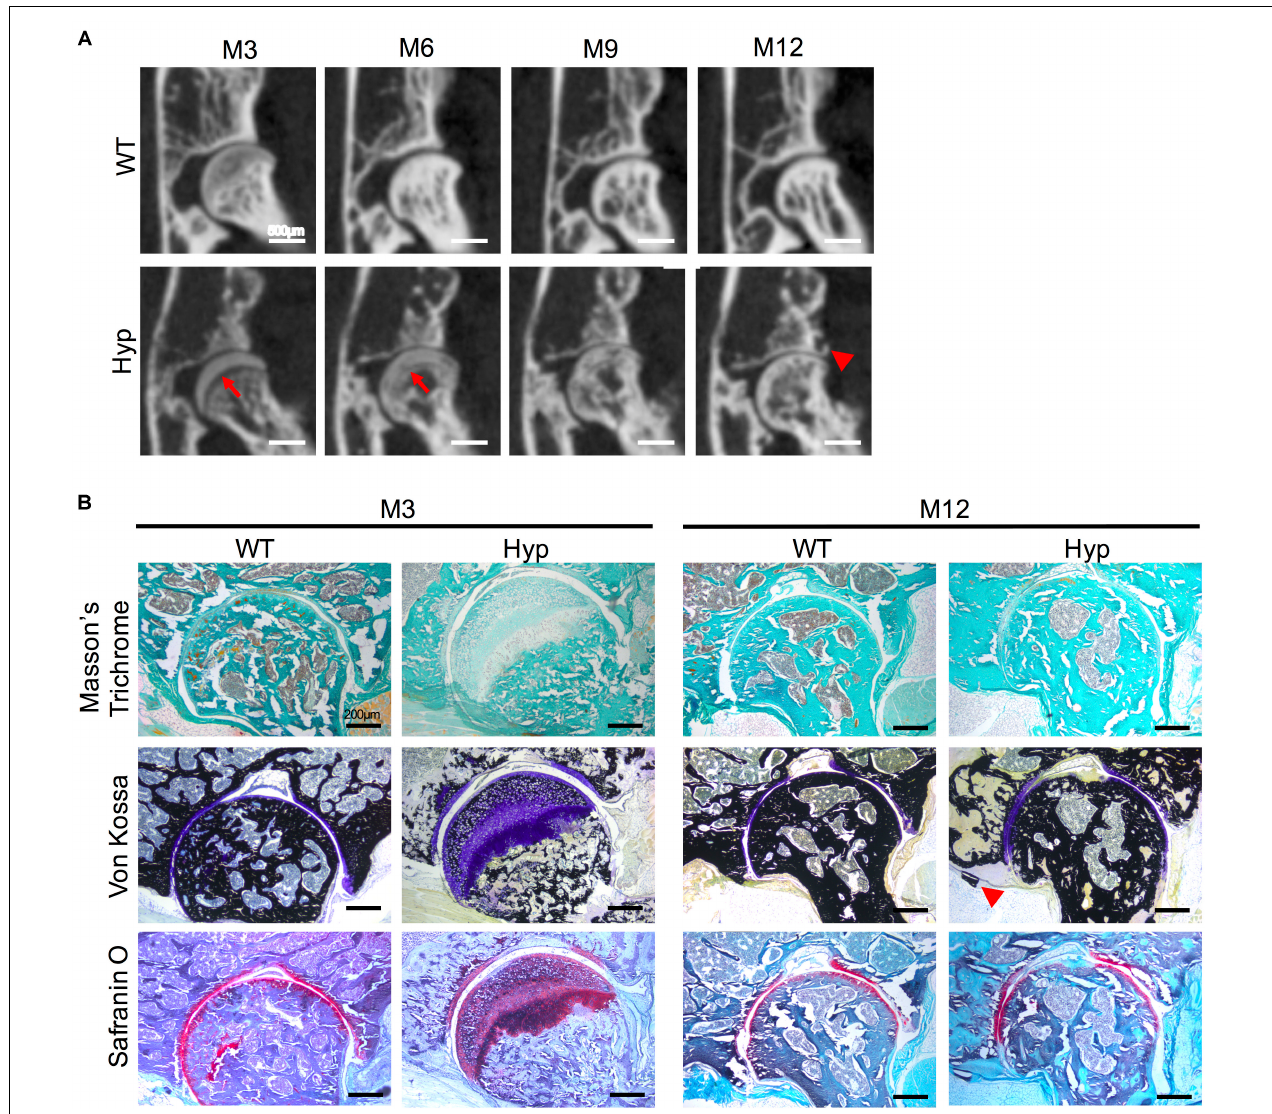
FIGURE 5 | Features of coxofemoral joint of Hyp and WT mice. (A) Delayed ossification was observed in Hyp mice on micro-CT (red arrows). New bone formation was noticeable at M12 in Hyp mice (red arrowhead) (representative micro-CT sections from Hyp# 2 mouse) (scale bars, 500 µ m). (B) Histological staining confirmed micro-CT observations. High thickness of the non-mineralized cartilage at M3 on Von Kossa staining was evident in Hyp mice which is confirmed by safranin O staining. At M12, the new bone formation was also observable on Von Kossa staining in Hyp mice (red arrowhead) (scale bars, 200 µ m).